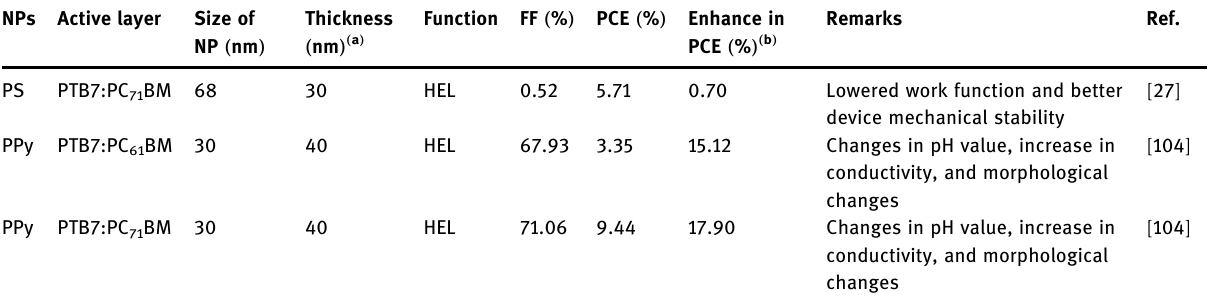
Table 6: Device characteristics of OPVs with organic NPs - doped PEDOT:PSS NPs Active